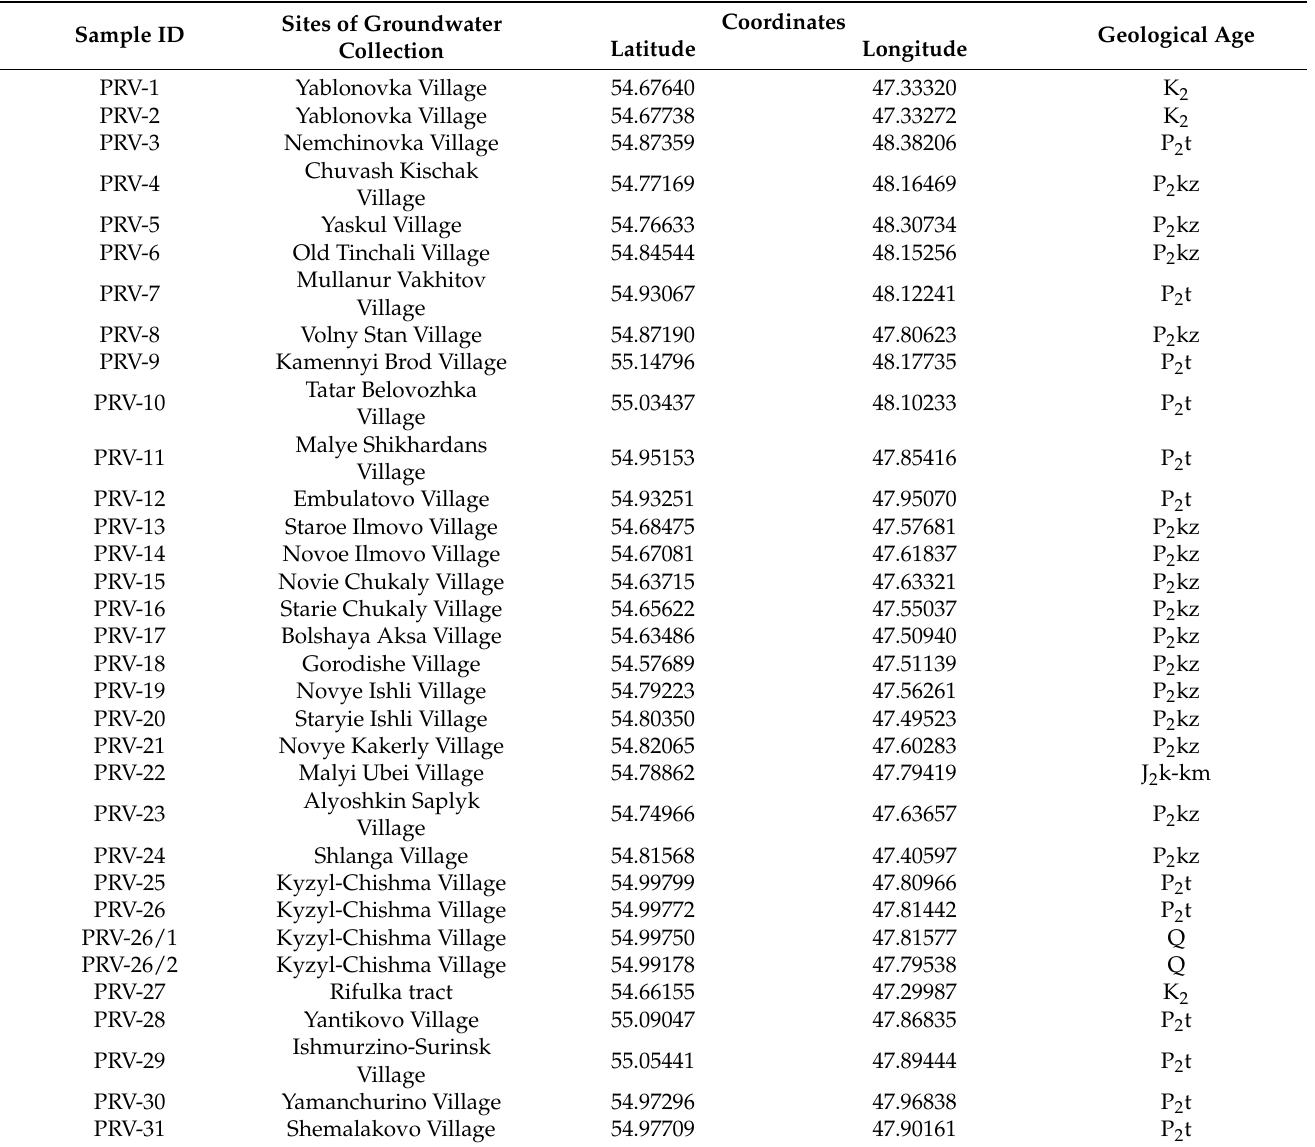
Table A1. Groundwater sampling points in the Pre-Volga